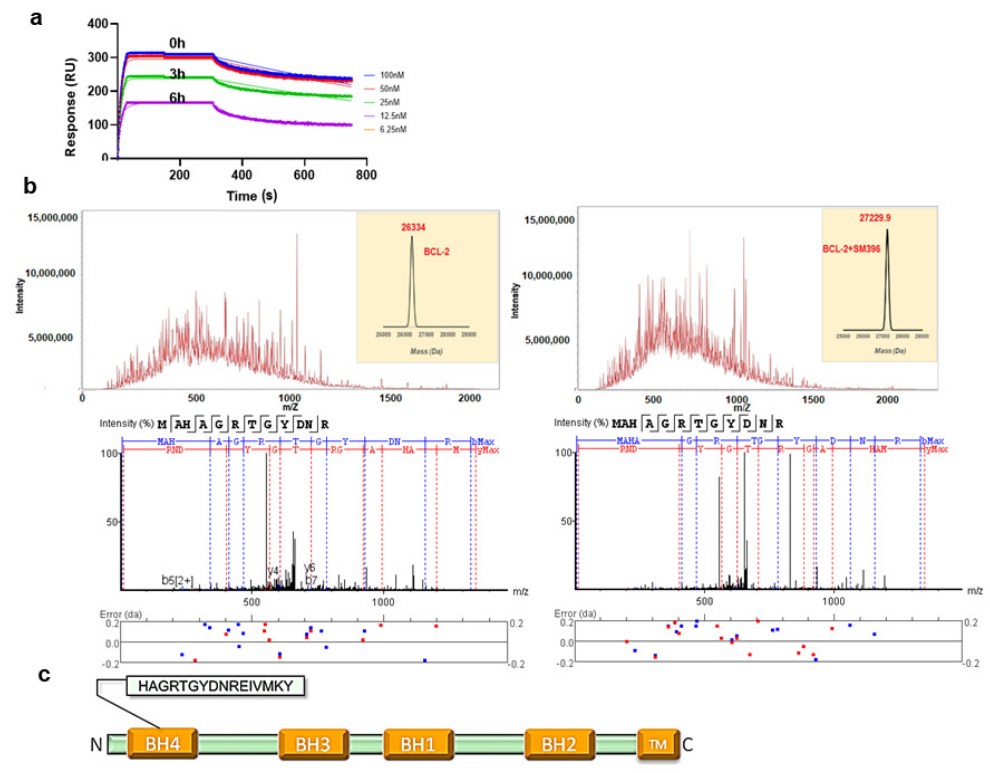
Figure 2. SM396, a covalent BH4 inhibitor. ( a ) The SPR sensorgrams for the interaction between immobilized BCL-2 and SM396 upon incubation with 1 µ M of SM396 for the indicated times of 0 h, 3 h, and 6 h. ( b ) Raw spectra and deconvoluted mass weights of molecular weights (right) for unmodified and SM396-modified BCL-2 are shown. MW (unmodified, calc): 26,334; MW (modified, calc): 27,229.7 Da with mass addition of 895.7 Da corresponding to SM396. Representative MS2 spectrum corresponding to BCL-2 is shown below, with b+ and y+ peaks annotated. The observed peaks are consistent with the BH4 domain sequence of human BCL-2. ( c ) Domain structure of BCL-2 with BH4 domain sequence